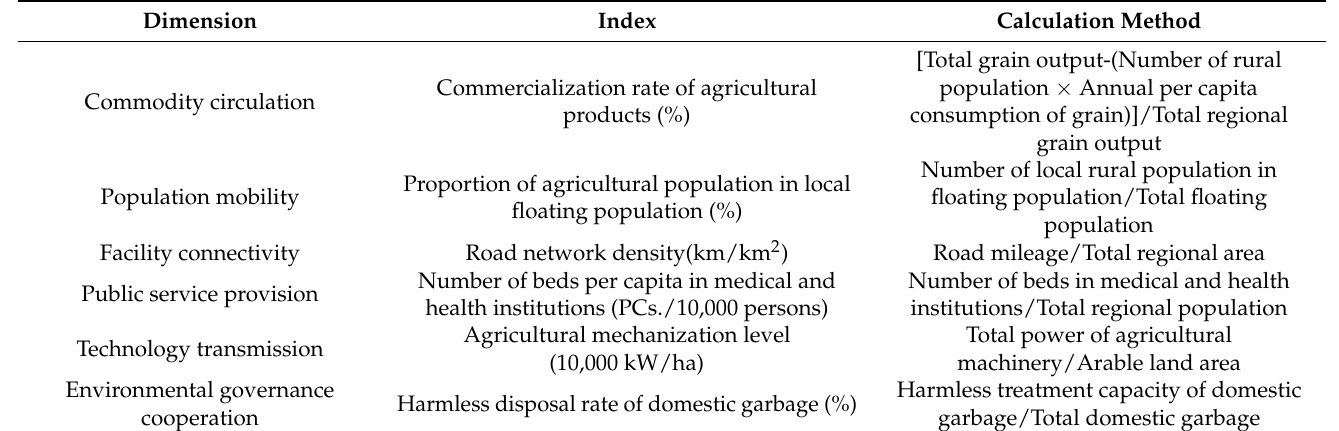
Table 1. Measurement index system of URID